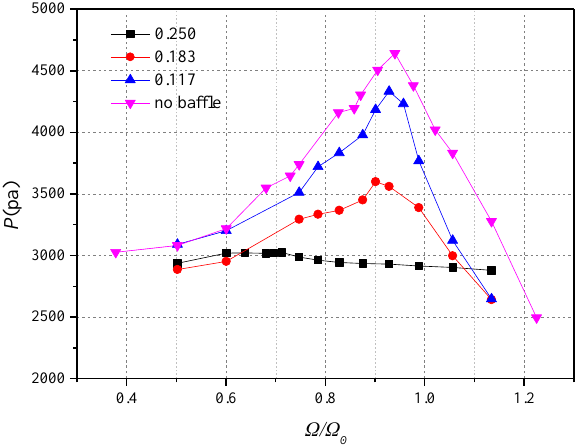
Figure 8. Comparisons of impact pressure under different installation heights of the horizontal baffles.